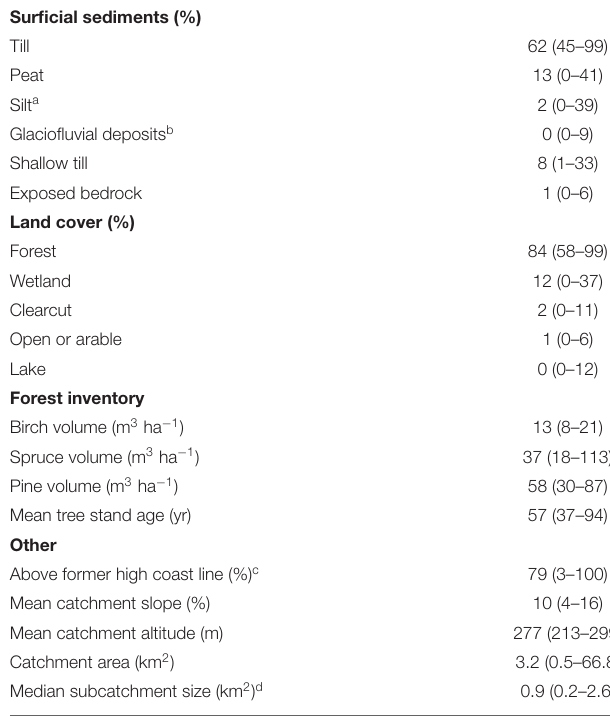
TABLE 2 | Median (range) of catchment characteristics for 47 electrofishing